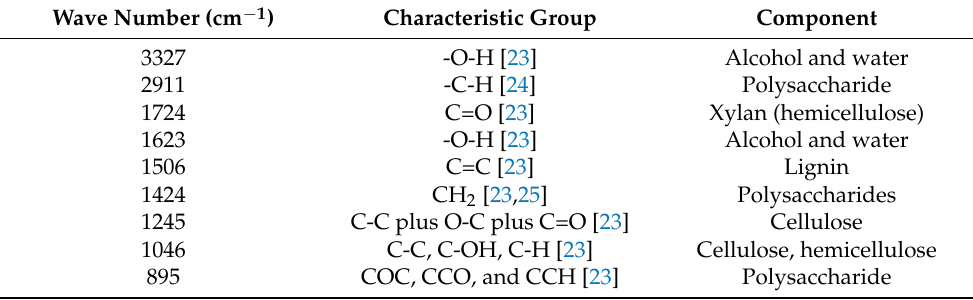
Table 2. Date palm tree fiber FTIR spectrum bands’ attribution.